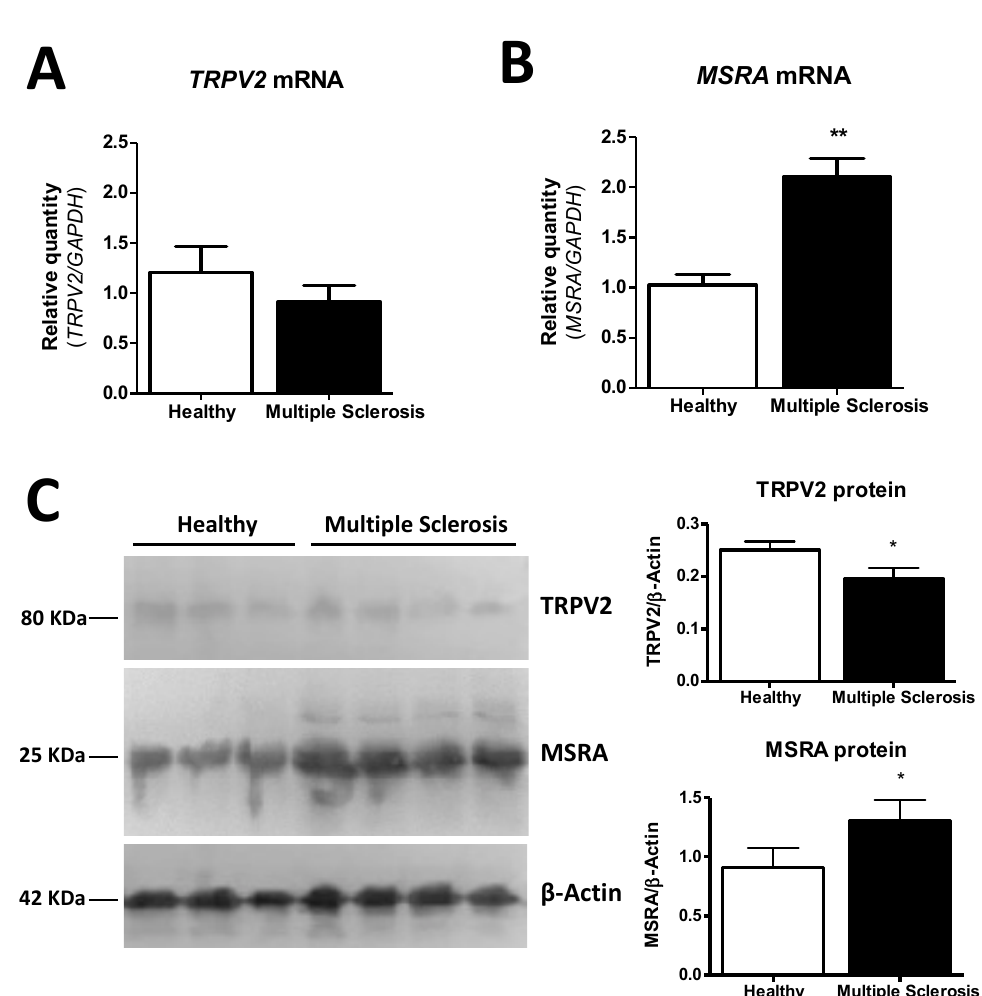
Figure 6. MSRA and TRPV2 expression in frontal cortex samples from healthy subjects ( n = 4) and MS ( n = 6) patients. ( A ) TRPV2 mRNA ( p = 0.3314) is not changed between MS and healthy samples. ( B ) A significant upregulation in MSRA mRNA ( p = 0.0014) is found in MS; ( C ) A significant decrease in TRPV2 protein levels ( p = 0.0232) and a significant increase in MSRA protein levels ( p = 0.0124) were determined in MS samples by western blot. Bars show mean ± SEM; * p < 0.05, ** p < 0.01 using unpaired Student’s t -test.